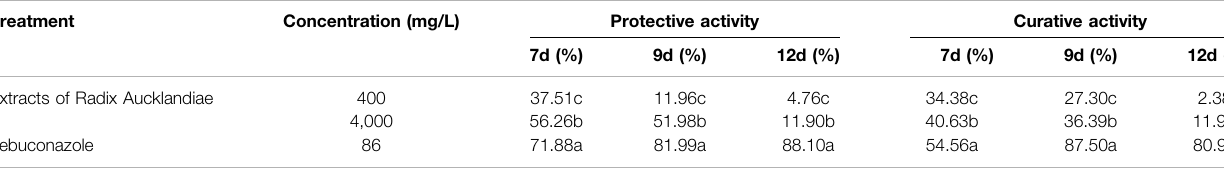
TABLE 3 | RDCE of extracts of Radix Aucklandiae on wheat head blight.